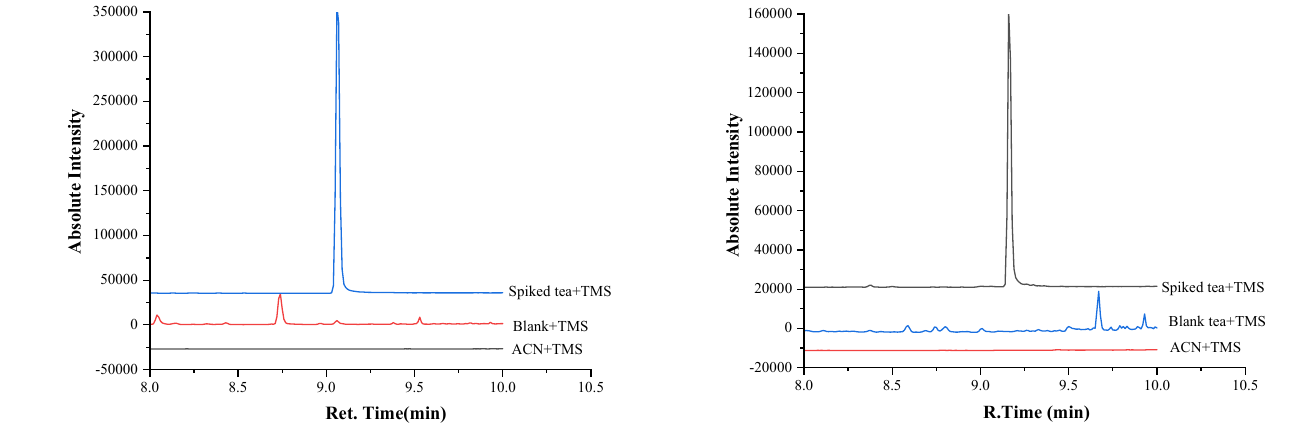
Figure 4. GC−MS SIM profiles at m/z 194 for NBA (left) and m/z 183 for PAT (right) of blank black tea spiked with 3-NBA (I.S.) and PAT, both at 5.0 ng/g.